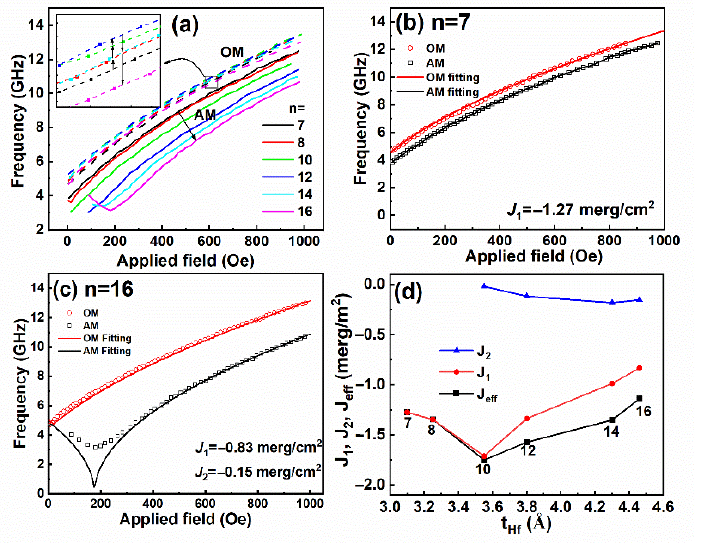
Figure 7. ( a ) The f–H curves of samples at n = 7–16 in EA-T mode; ( b,c ) the experimental and simulation results for representative samples at n = 7 and 16, respectively; ( d ) the hafnium thickness dependence of interlayer coupling coefficients for samples at n =